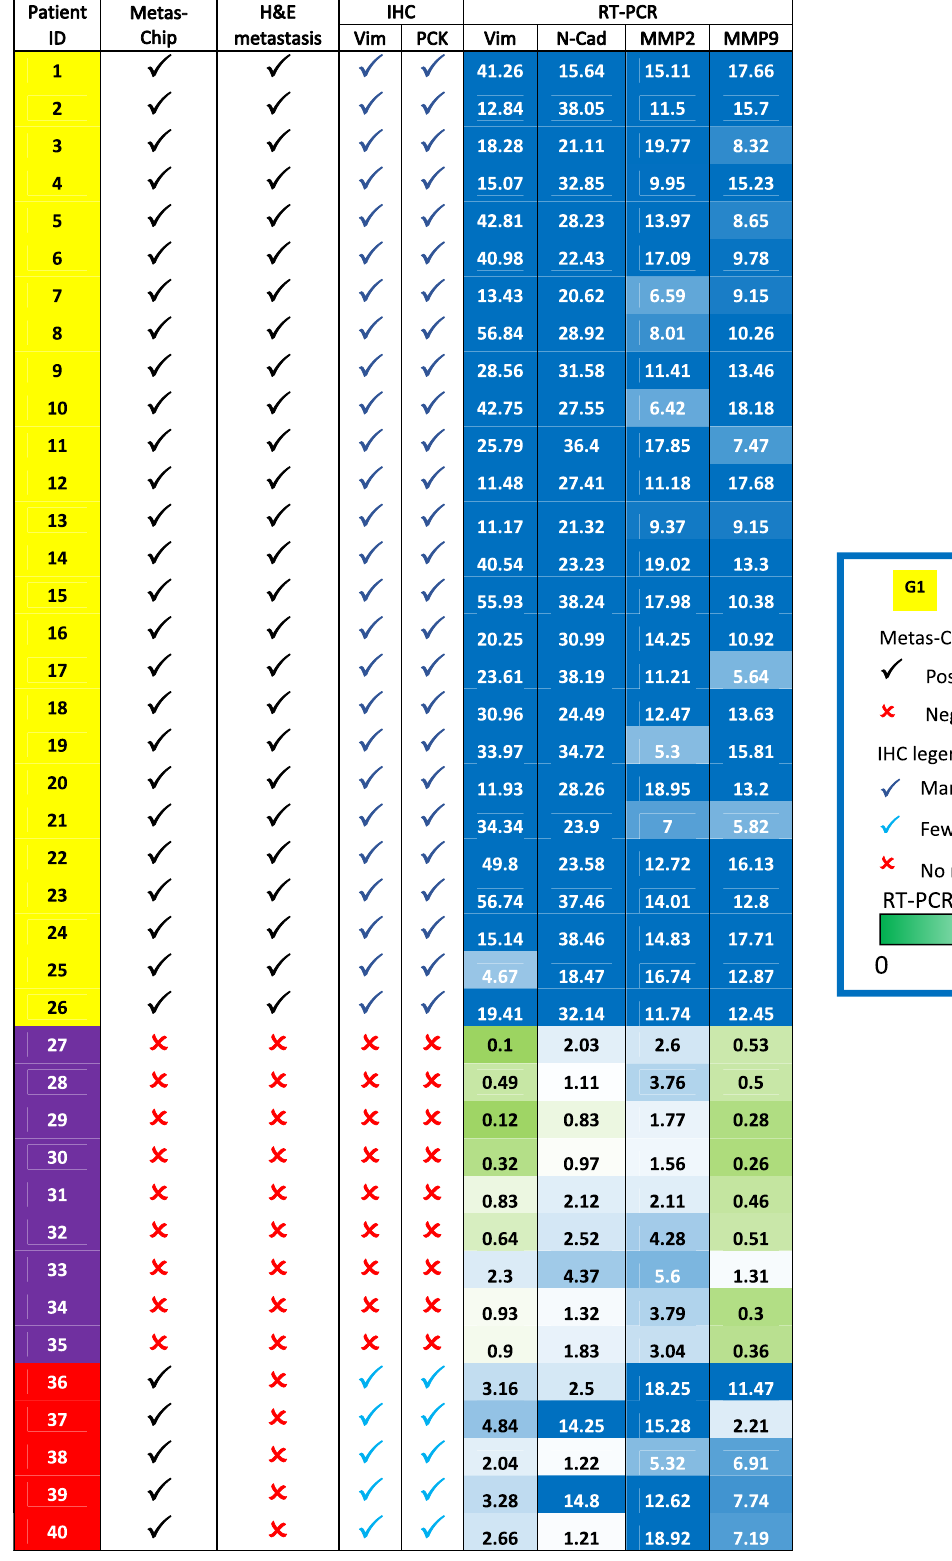
Table 1 Metas-Chip, H&E, IHC and RT-PCR diagnostic results of breast lymph nodes removed from breast cancer patients by